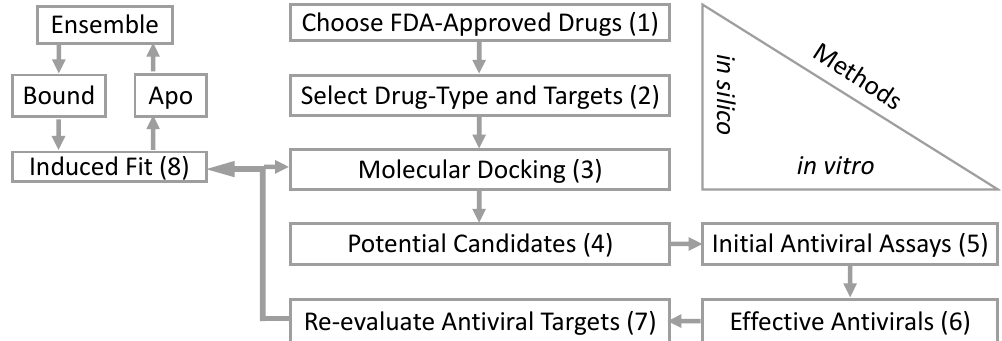
Figure 1. The workflow schematic indicates that a total of 1960 U.S. Food and Drug Administration (FDA)-approved drugs were downloaded from Drug Bank in the year 2017 (1). Excluding FDA-approved small molecule antiviral drugs (<900 daltons), only 73 were >1000 daltons. These 73 antivirals were then screened in silico with six Zika virus (ZIKV) proteins (2; Table 1). After the molecular docking screen (3), 12 FDA-approved antiviral drugs resulted in favorable scores (4). An in vitro assay of these 12 antivirals (5) resulted in three effective anti-ZIKV FDA-approved drugs (6). The drugs and targets were re-evaluated by searching the Protein Data Bank (PDB) for similar co-crystalized compounds (7). The molecular dockings were repeated using the average coordinates from various inhibitors. Finally, a series of induced fit simulations and dockings (8) were conducted on the favorable re-docked structures. The structures were then compared to similar co-crystalized compounds.